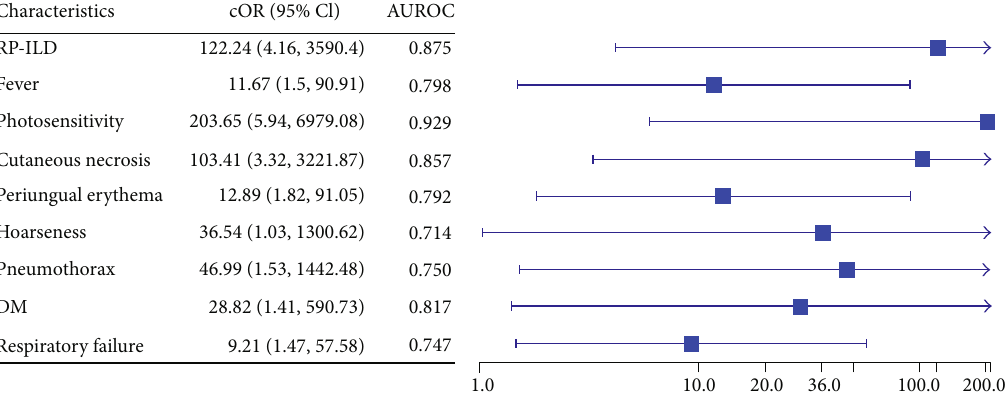
Figure 1: Characteristics signi fi cantly associated with anti-MDA-5-Ab-positive status.